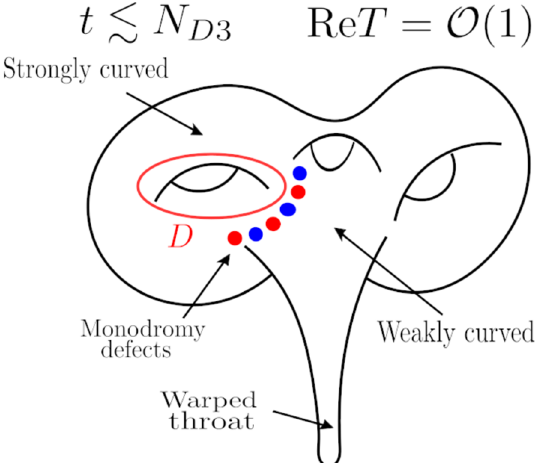
Figure 18 . Same CY as in figure 17, for small value of the volume modulus t . N D 3 and Re T = O (1) . The non-perturbative splitting of seven-branes has eaten up almost the entire bulk CY but has not yet entered the warped throat. The inside region (on the left) that has been swept up by the spreading of seven-branes is strongly curved, while the outside region (on the right) is still weakly